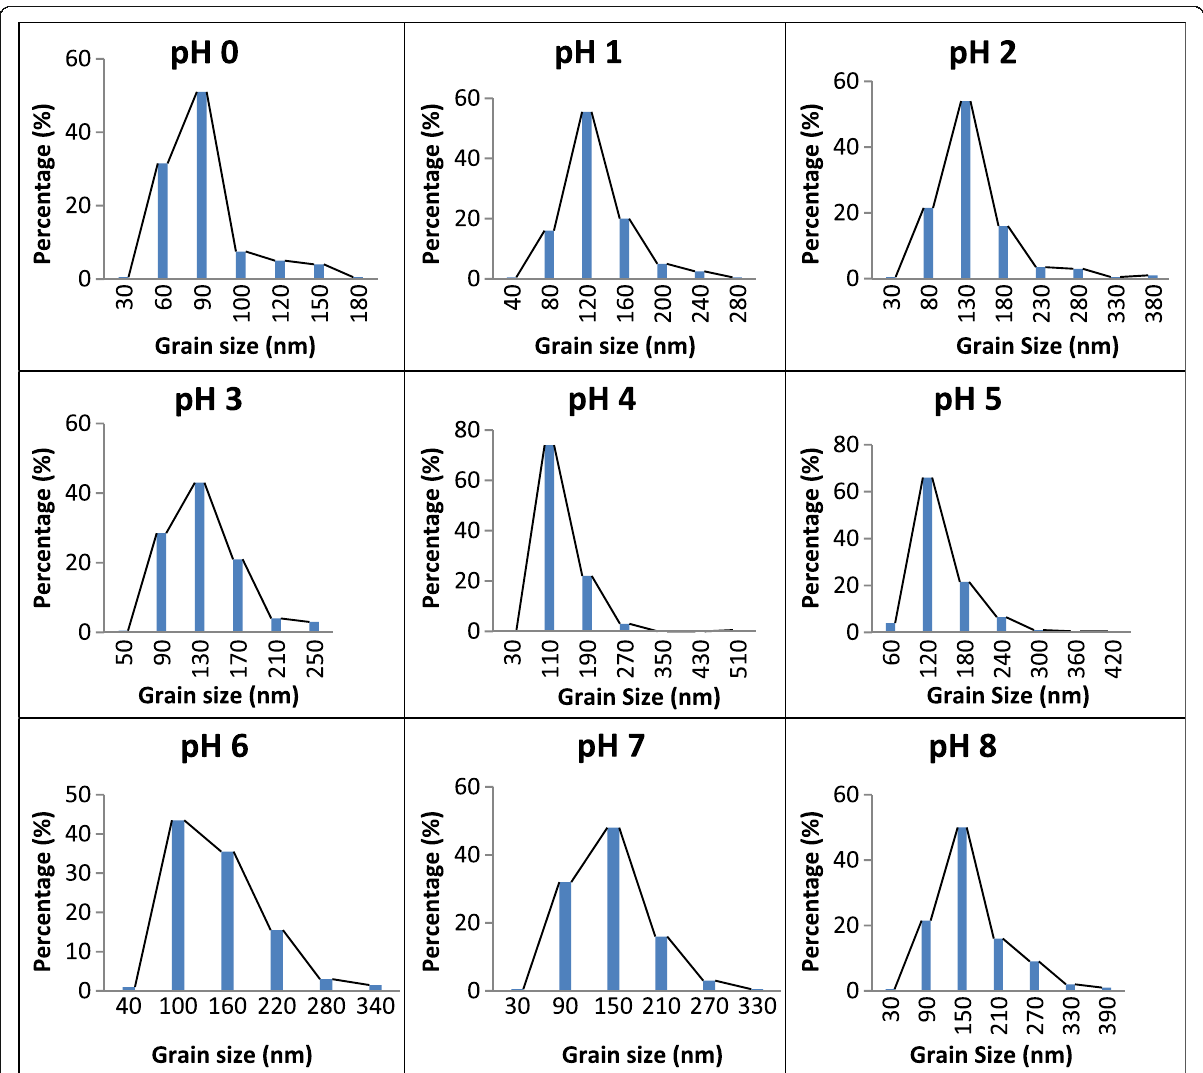
Fig. 7 Grain size distribution for SrFe 12 O 19 calcined at 900 °C by varying pH: a pH 0, b pH 1, c pH 2, d pH 3, e pH 4, f pH 5, g pH 6, h pH 7, and i pH